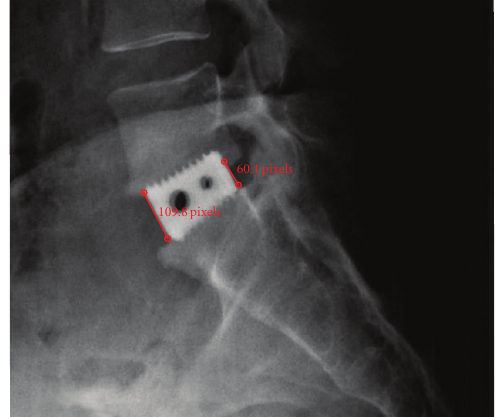
Figure 4: Measurement of scanned analog X-ray.